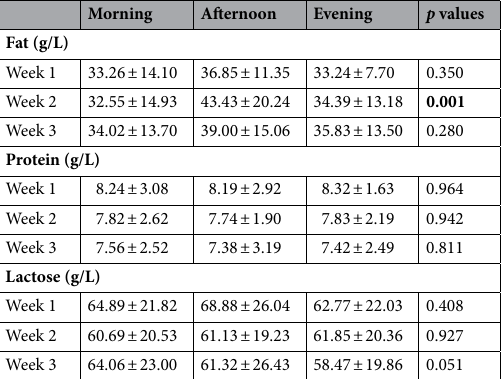
Table 3. Mean fat, protein and lactose concentrations in HM collected at different times of day across the 3 study weeks a . a Values are shown as mean ± standard deviation. A p value of <0.05 was considered statistically